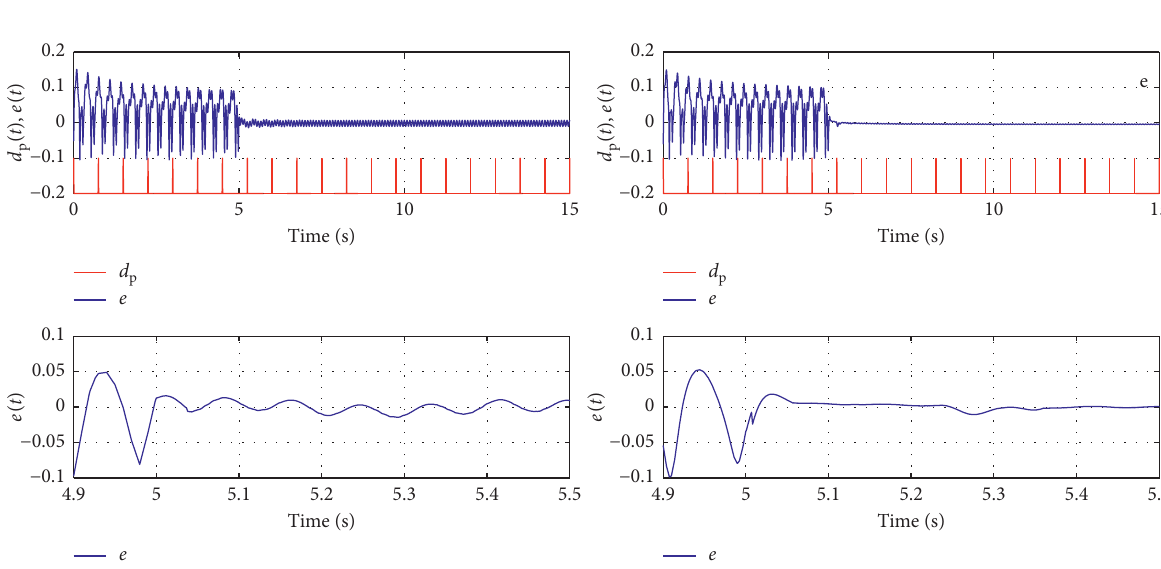
Figure 10: Tracking error of IOSM and NN-FFOSM in case